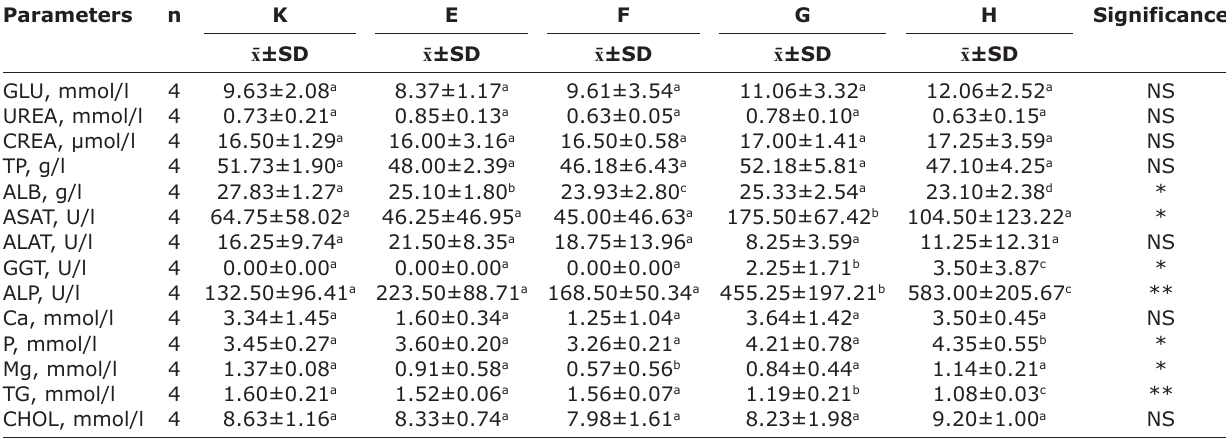
Table-5: Blood biochemical parameters of rainbow trouts ( Oncorhynchus mykiss W.). Parameters